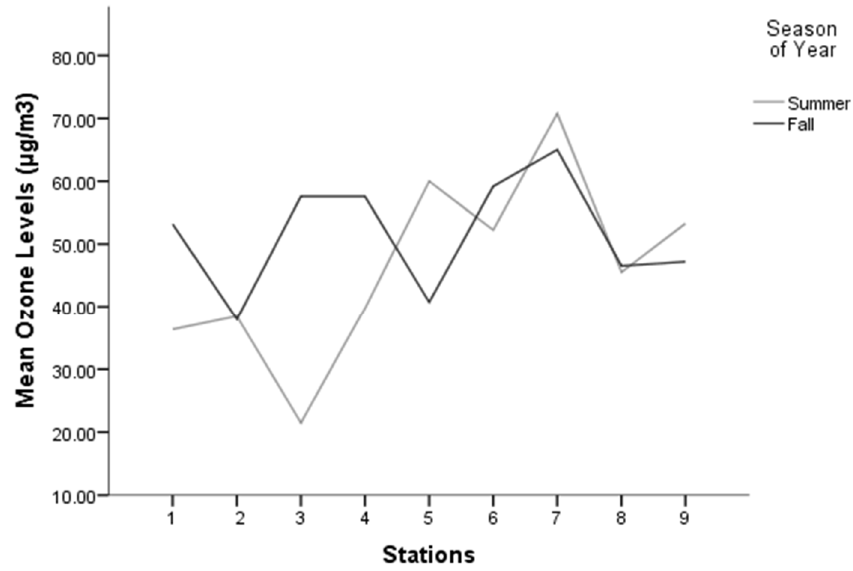
Figure 5. O 3 concentration for fall and summer 2019 at study locations .